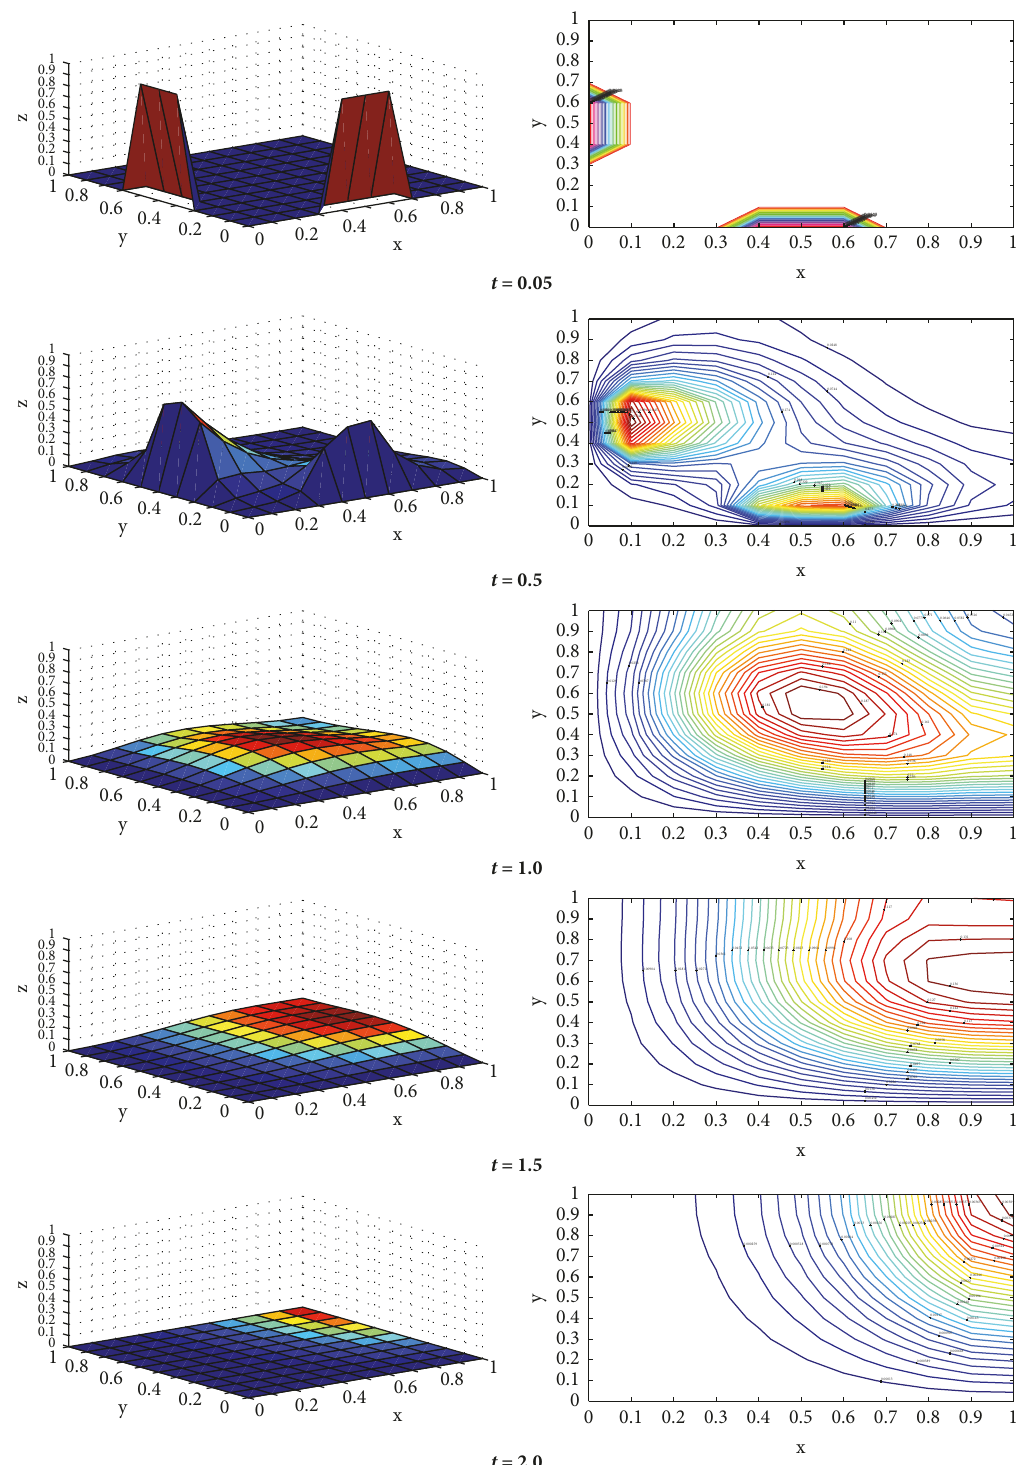
Figure 5: Pollutant distribution in a box model under the sea with advection in 𝑥 , 𝑦 , and 𝑧